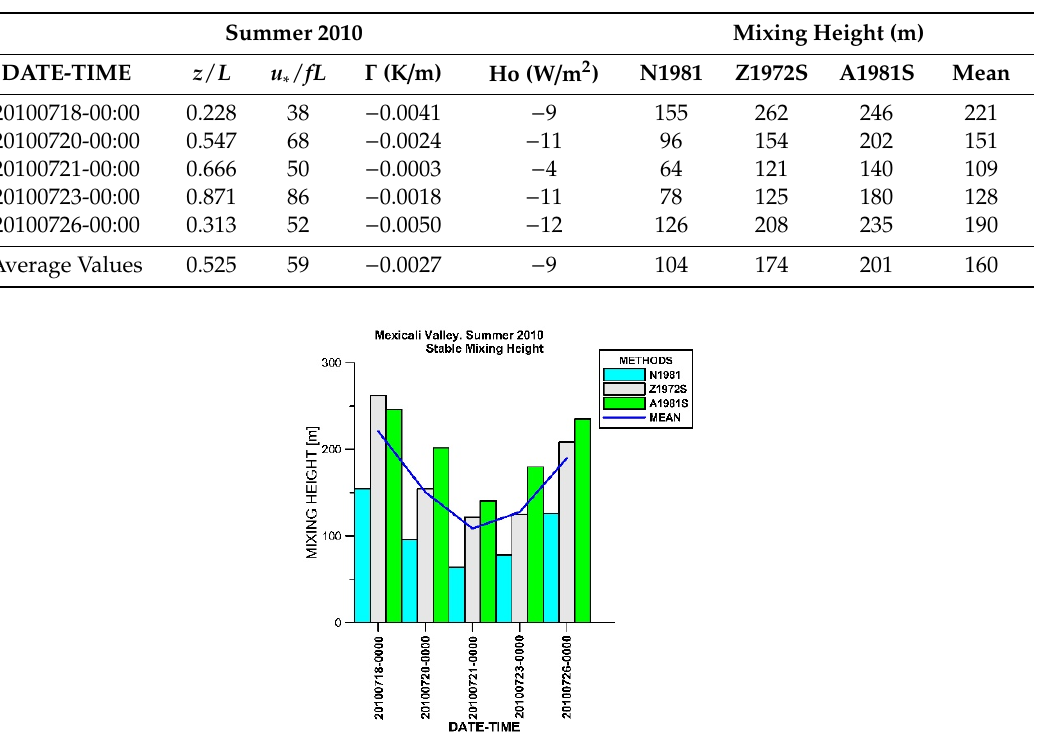
Table 7. The summer stable mixing height of the Mexicali Valley estimated with the surface mean values of friction velocity and Monin–Obukhov length according to the N1981, Z1972S, and A1981S. Here, we also included the mean surface values of the stability parameters and sensible heat flux, and the near-surface temperature lapse rate of the radiosonde (RS).